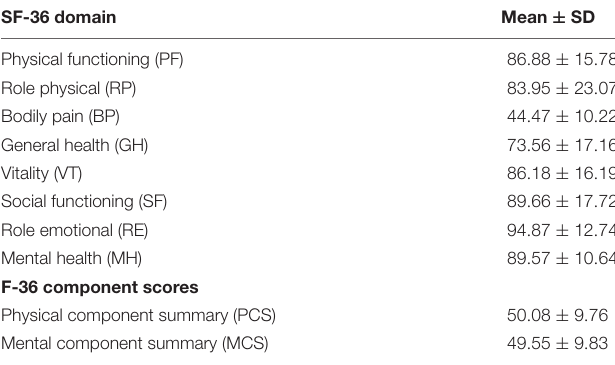
TABLE 3 | Descriptive statistics for SF-36 dimensions ( n = 104).